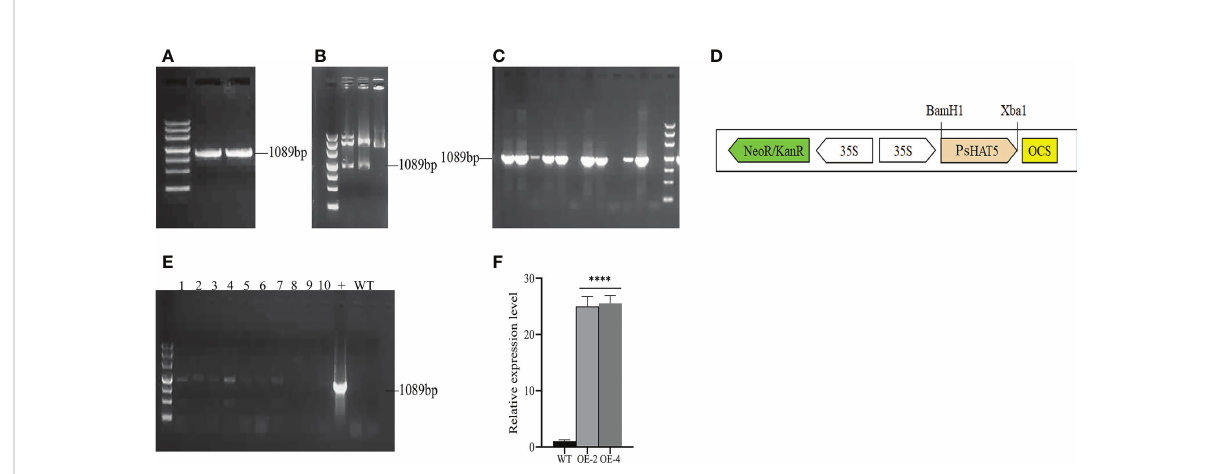
FIGURE 2 (A-D) : The plant Overexpression vector construct of PsHAT5 . (A) Cloning of PsHAT5 gene. (B) The recombinant plasmid pCAMBIA2300-35S- PsHAT5-Nos was identi fi ed by restriction enzyme digestion. (C) Identi fi cation of PsHAT5 gene by Agrobacterium tumefaciens GV3101. (D) pCAMBIA2300-35S-PsHAT5-Nos Expression Frame. (E, F) PCR identi fi cation of transgenic tomatoes with PsHAT5 gene. (E) PCR identi fi cation of transgenic plants. Numbers 1-10 indicate individual transgenic plant lines, the “ + ” plasmid was used as a positive control, and WT were used as negative controls. (F) Relative expression levels of transgenic tomatoes. (****P < 0.0001 for comparisons between the transgenic lines and wildtypeplants by Student ’ s